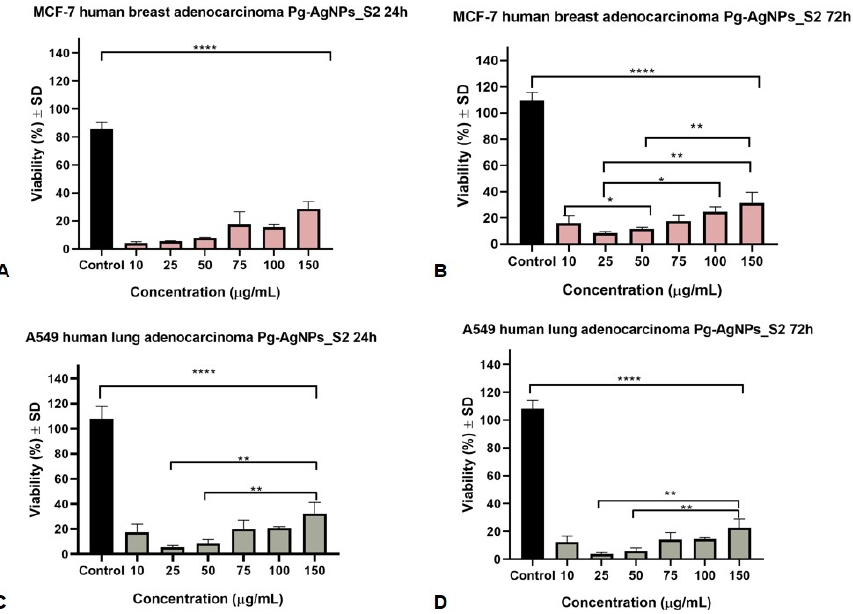
Figure 6. MCF7 and A549 cells viability after 24 and 72 h stimulation with Pg-AgNPs_S2 (10, 25, 50, 75, 100 and 150 µg/mL). ( A )—24 h treatment of MCF7 cells; ( B )—72 h treatment of MCF7 cells; ( C )—24 h treatment of A549 cells, ( D )—72 h treatment of A549 cells. The results are expressed as cell viability percentage (%) related to the Control cells. Comparison among groups was made using the one-way ANOVA test followed by Tukey’s test. A p -value of ≤ 0.05 was considered to be of statistical significance (* p ≤ 0.05; ** p ≤ 0.01; **** p ≤ 0.0001).